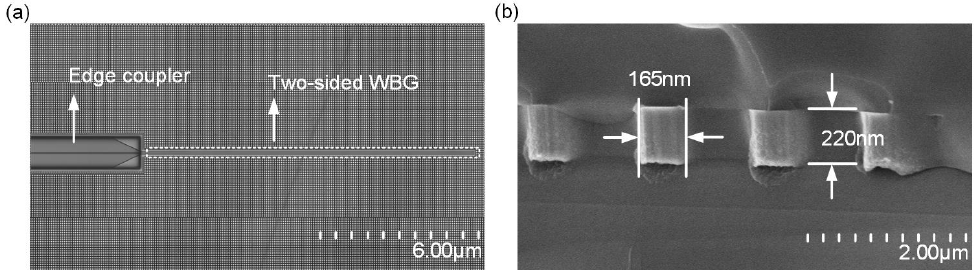
Figure 5. SEM image of two-sided WBG: ( a ) Top view; ( b ) Cross-sectional view.